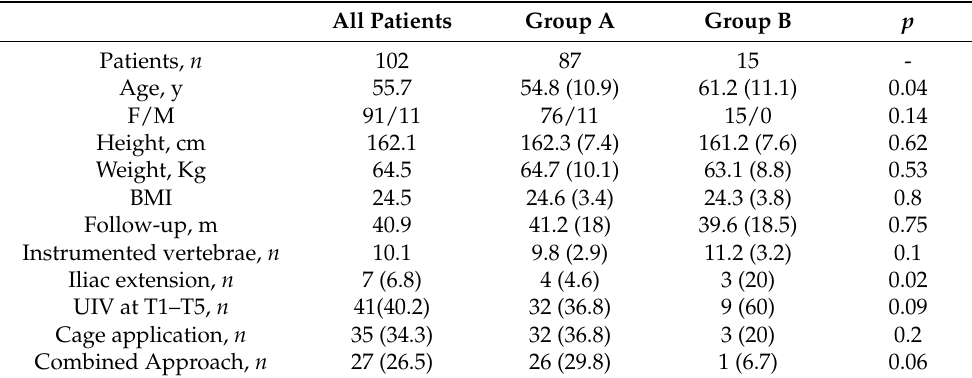
Table 3. Demographic and surgical data; mean [standard deviation] or (% of